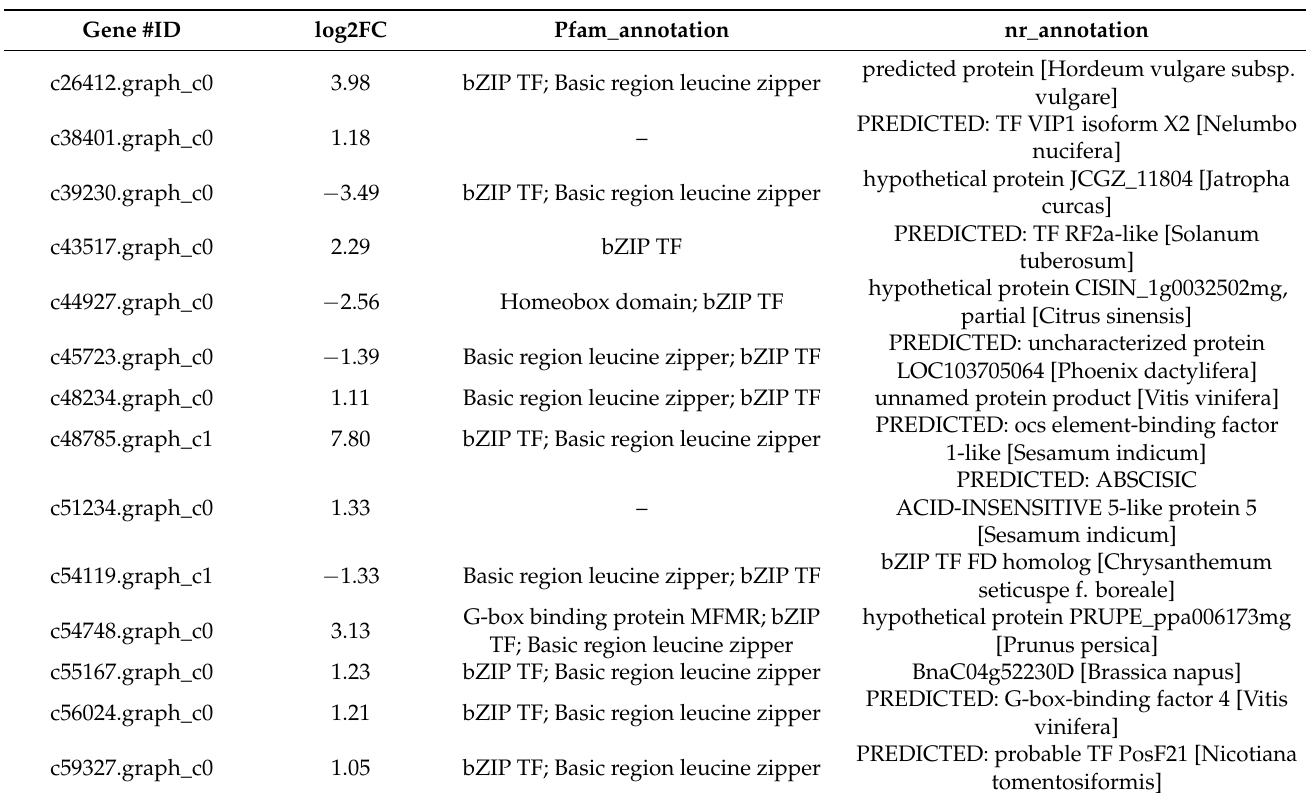
Table 1. Annotation of differentially expressed bZIP TFs in salt-treated and control plants of C. grandiflora